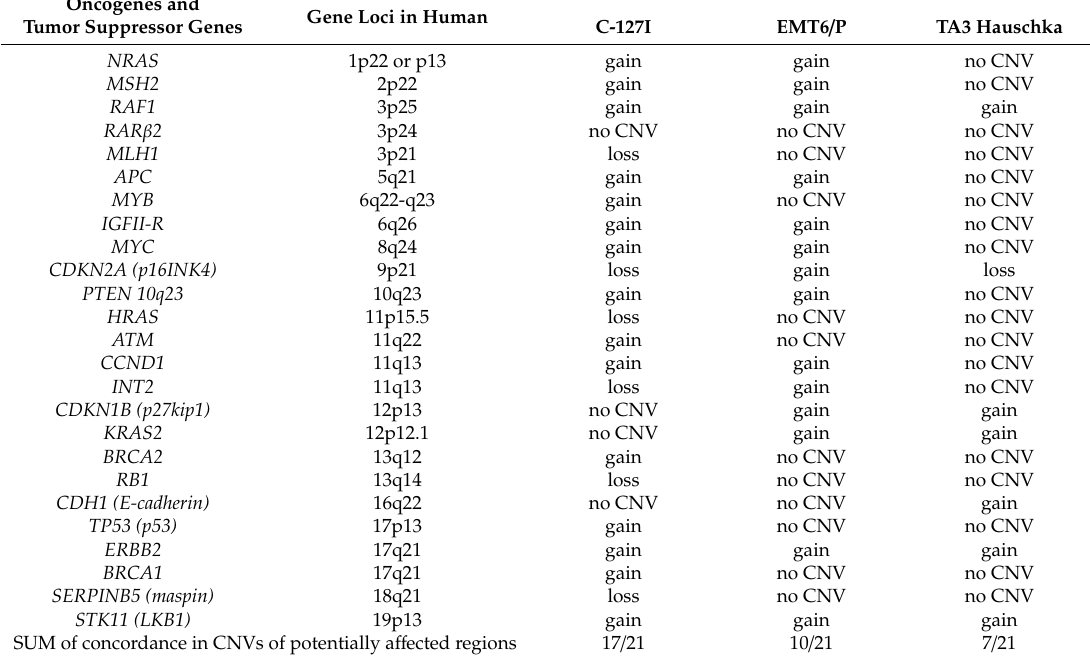
Abbreviation: CNV = copy number variant.